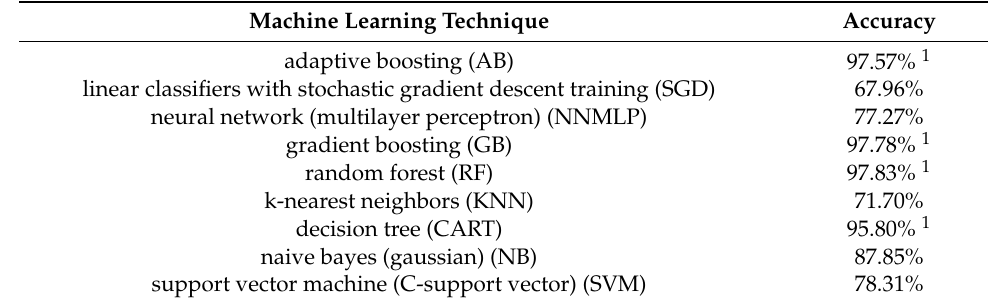
Figure 5. Accuracy comparison of the considered machine learning techniques. Table 5. Obtained accuracy of each machine learning technique.